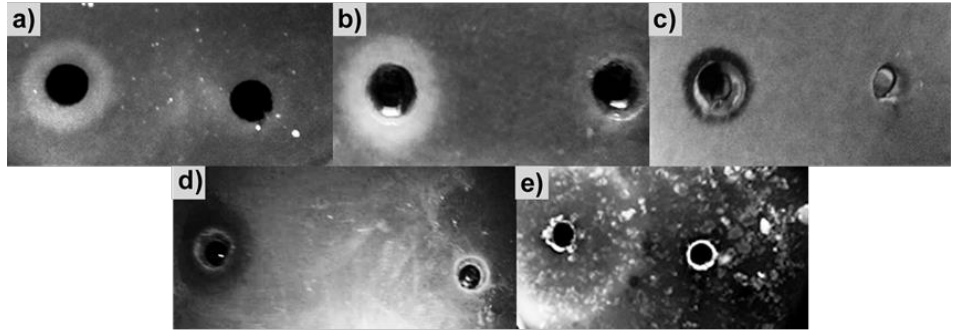
Figure 4. Specificity of BlpLc action with respect to different substrates: ( a ) gelatin, ( b ) azofibrin, ( c ) elastin, ( d ) hemoglobin, and ( e ) collagen.